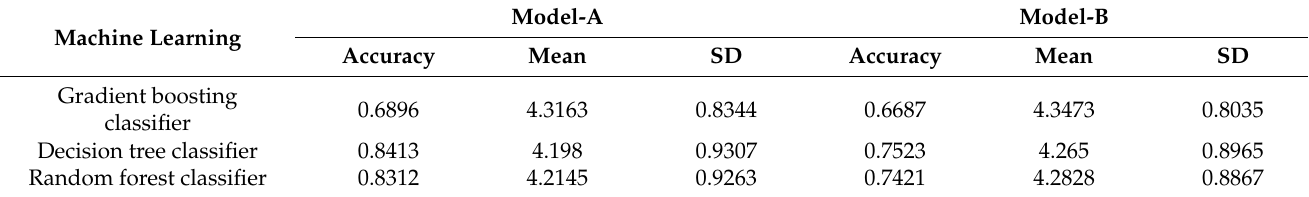
Table 4. Accuracy achieved with different machine-learning methods.